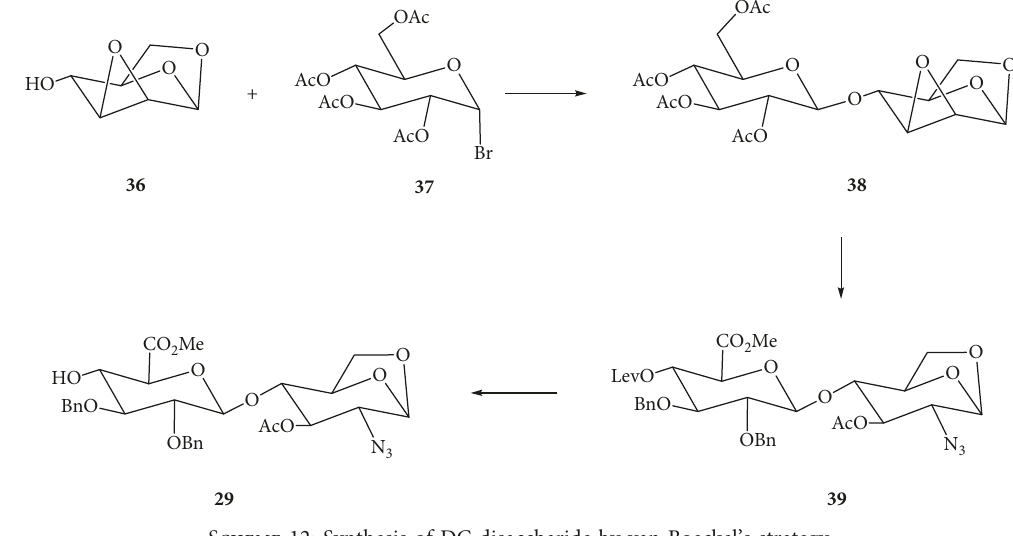
Scheme 12: Synthesis of DC disaccharide by van Boeckel’s strategy.